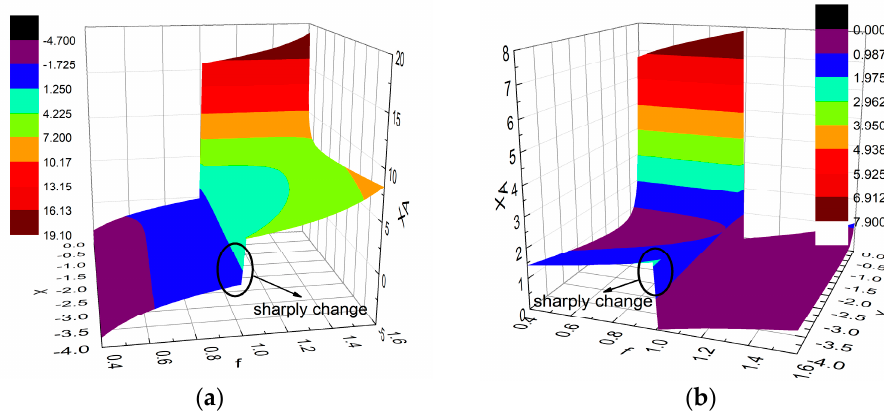
Figure 4. Relationships between X A , X , and f : ( a ) relationship expressed by (11); ( b ) relationship expressed by (12).